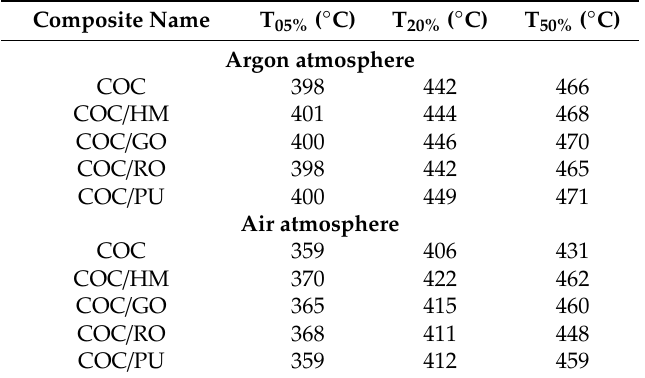
Figure 10. TGA curves obtained for COC composites filled with different earth pigments measured in air atmosphere. Table 3. Thermal decomposition temperatures for COC composites filled with different earth pigments (standard deviation of T 05,20,50% = ±3 °C).